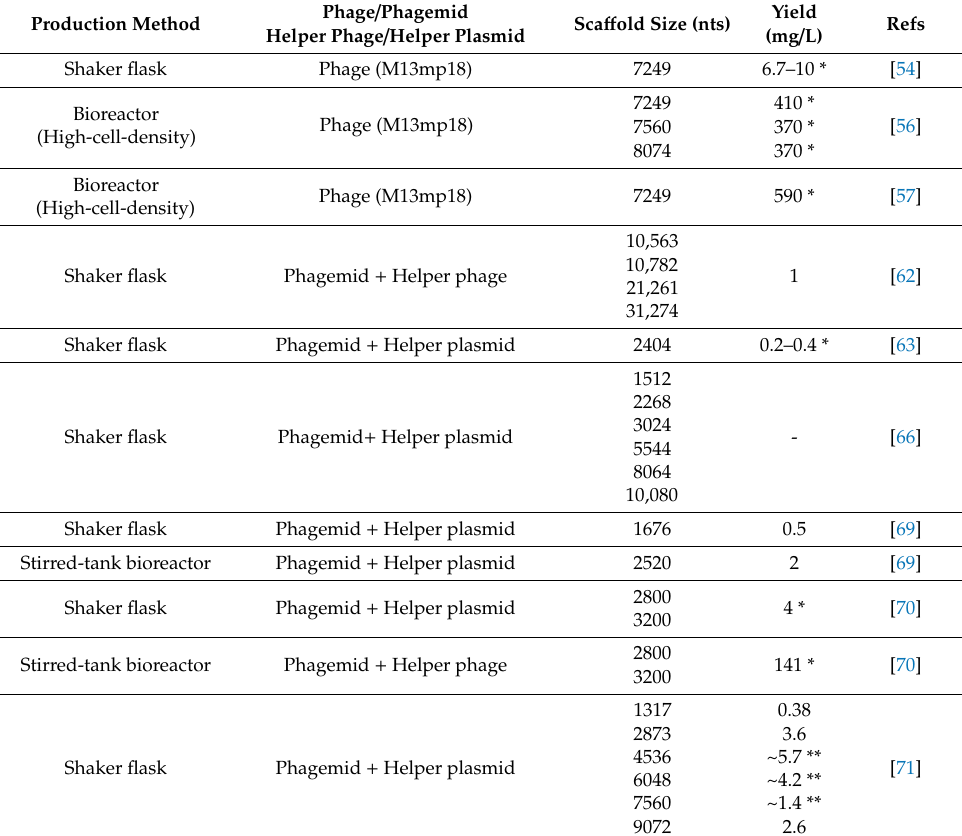
Table 1. Overview of bacteriophage-based ssDNA